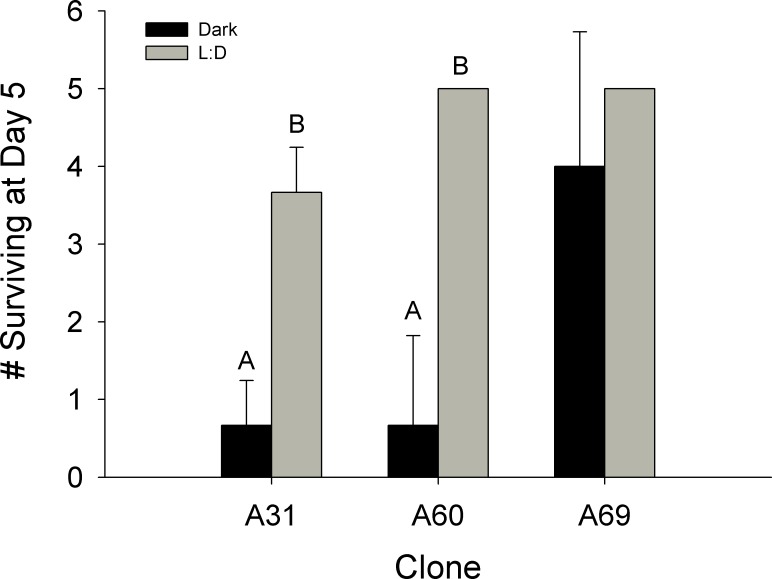
Survival of D. parvula.Number Daphnia parvula surviving to Day 5 for each of three clones held under dark and L:D conditions. Capital letters designate significant statistical differences between treatments within a clone. Effects of dark conditions on only some clones should be noted.